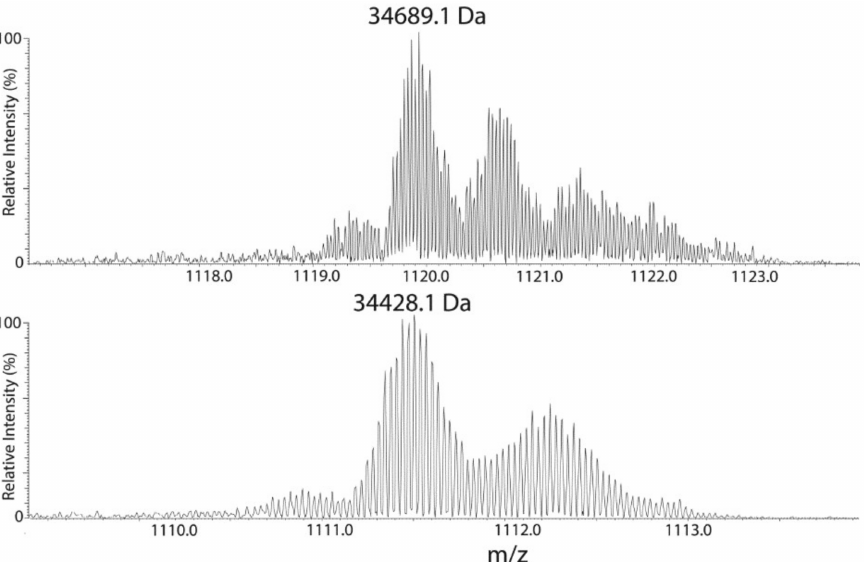
Figure 7. Heterogeneity of His-D2/ ∆ CP47 protein species eluted from a RP HPLC PLRP/S column at 43 and 51 min. The 51 min fraction contains a modestly heterogeneous protein of average mass 34,689 Da, and other species differing in fatty acid chain lengths. A less hydrophobic protein of 34,428 Da eluted at 43 min protein is less heterogeneous. The difference of 261 Da between both proteins corresponds to the loss of an 18:2 or 18:3 fatty acid from the 34,689 Da